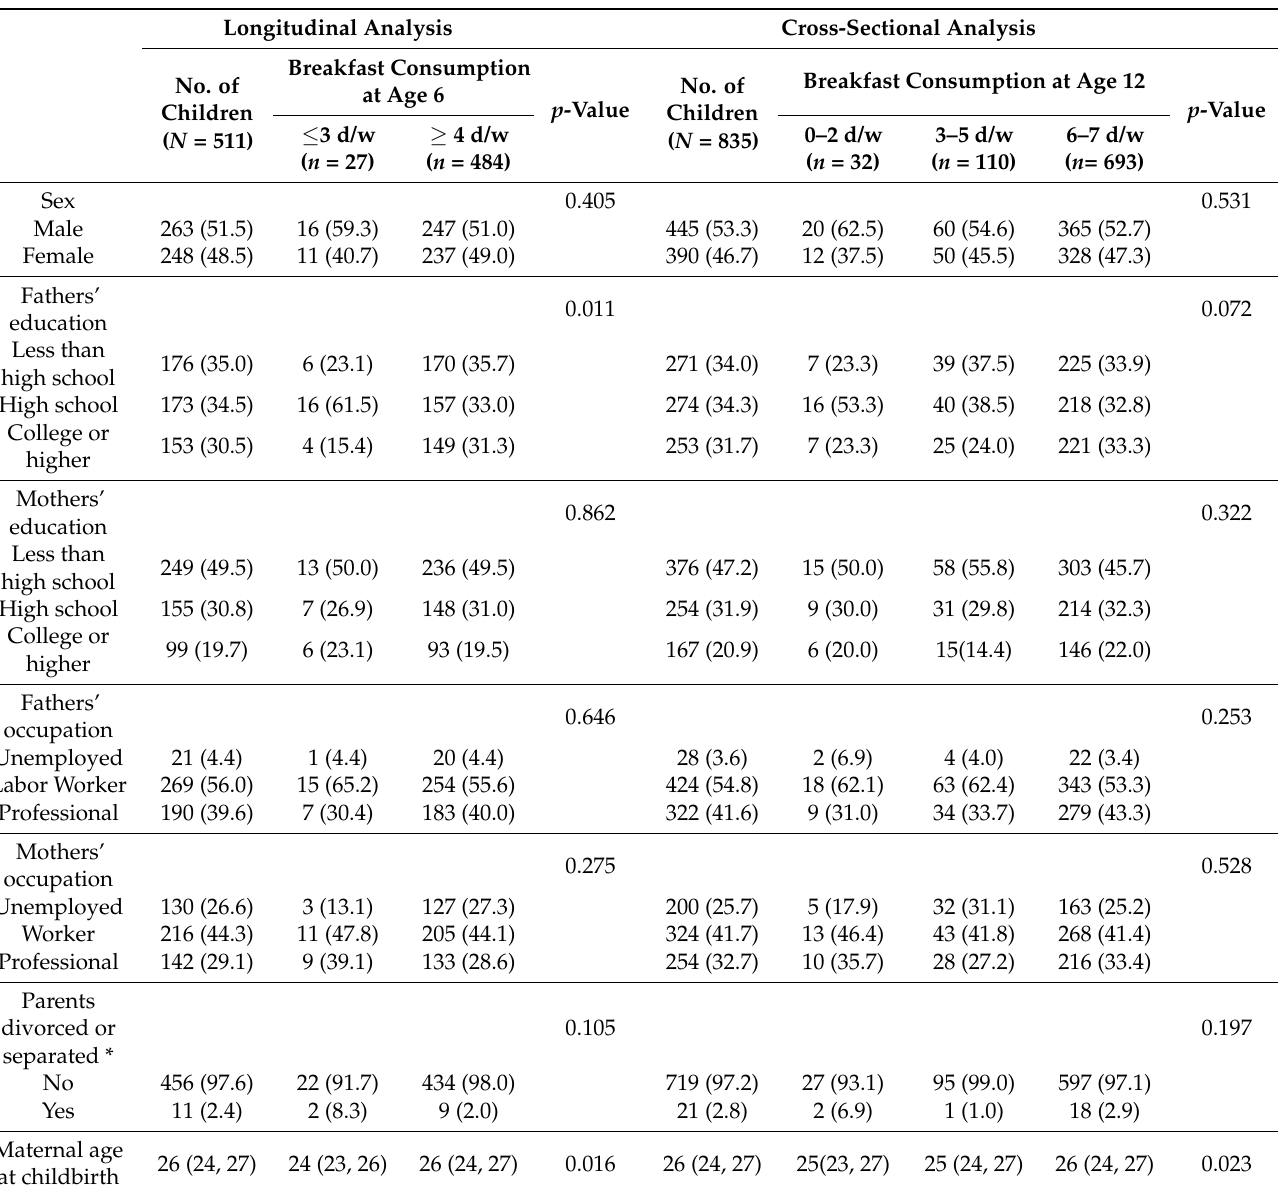
Table 1. Descriptive characteristics by breakfast consumption